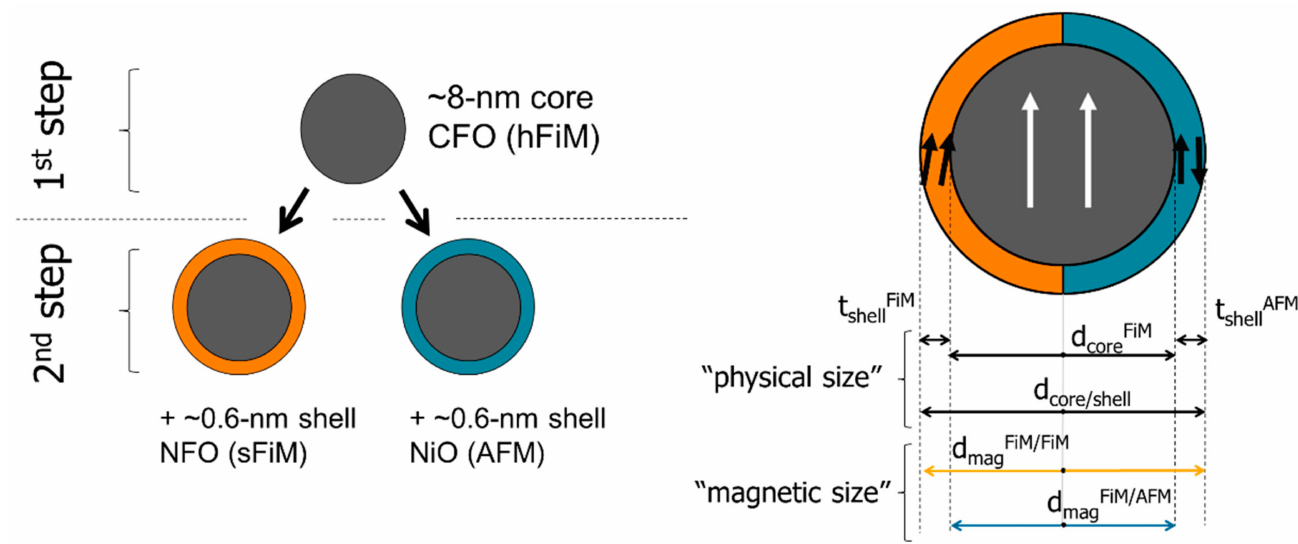
Figure 7. Schematic representation of the magnetic structure of CFO/NFO and CFO/NiO core/shell samples. Interestingly, despite the very low thickness, the presence of different shells can affect not only single-particle behavior but also has a notable effect on the interparticle interaction strength. Indeed, the s-FiM shell increases the negative value of δ m, suggesting a higher impact of the dipolar interactions, while the NiO shell prevents such interactions. The <T B > of the CFO/NiO sample was approximately equal to that of the CFO; however, given that it is proportional to the anisotropy barrier (<T B > ∝ KV), and considering that both systems have the same magnetic size, one expects the higher <T B > value for the sample with the higher anisotropy. This can be attributed to the significant effect of temperature on the interface component of magnetic anisotropy as well as the effect of interparticle interactions on the anisotropy energy